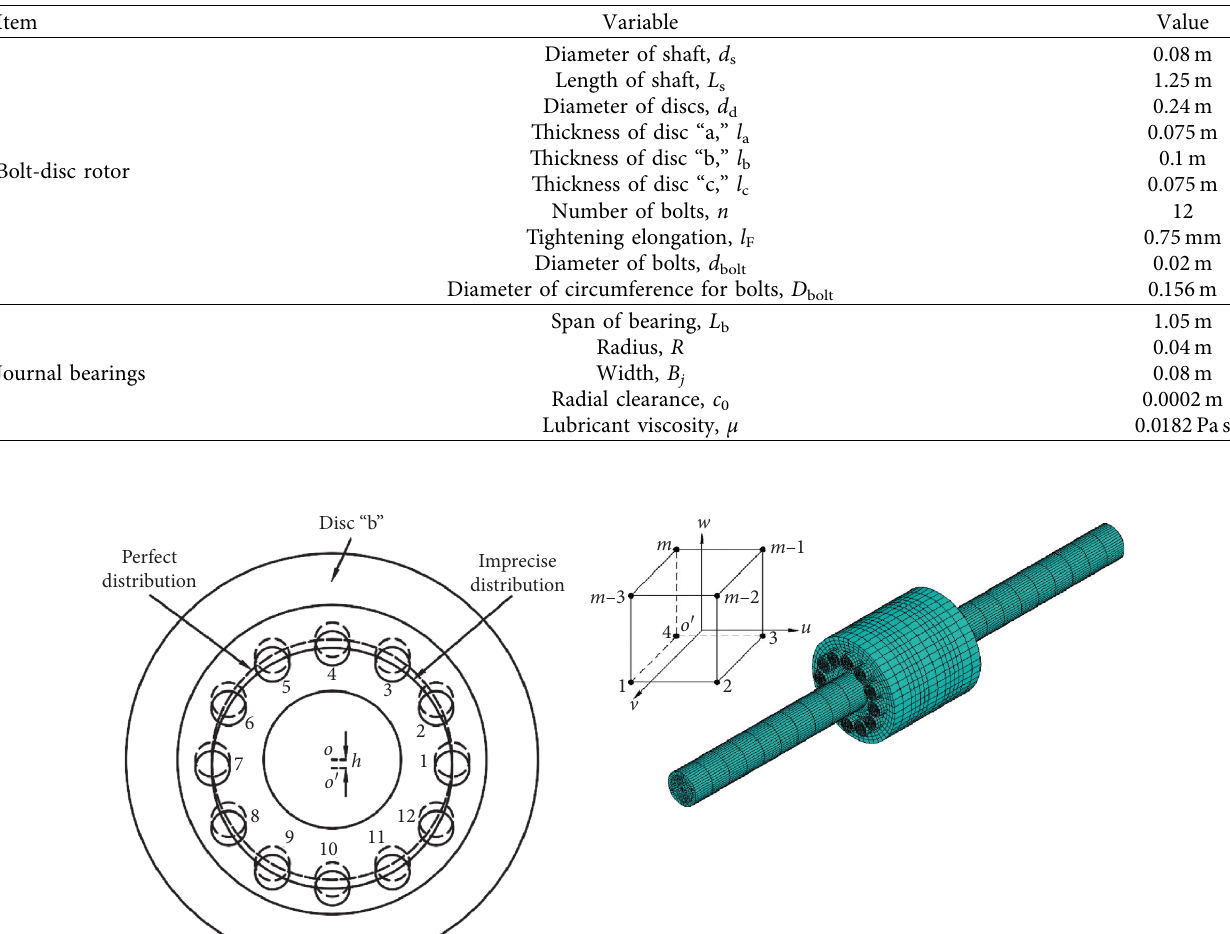
Figure 2: Typical bolt-disc rotor bearing system. Table 1: Variables of the bolt-disc rotor bearing